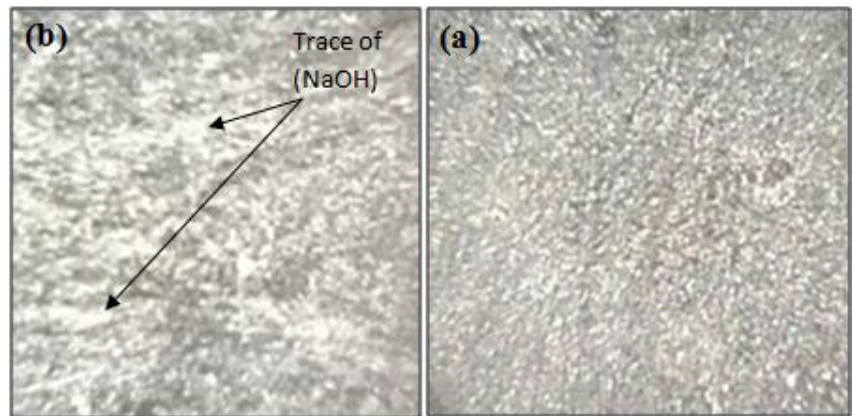
Fig. 8: The images of surface of sample (Ep + 4wt% of MWCNTs). (a) Before immersion. (b) After immersion.